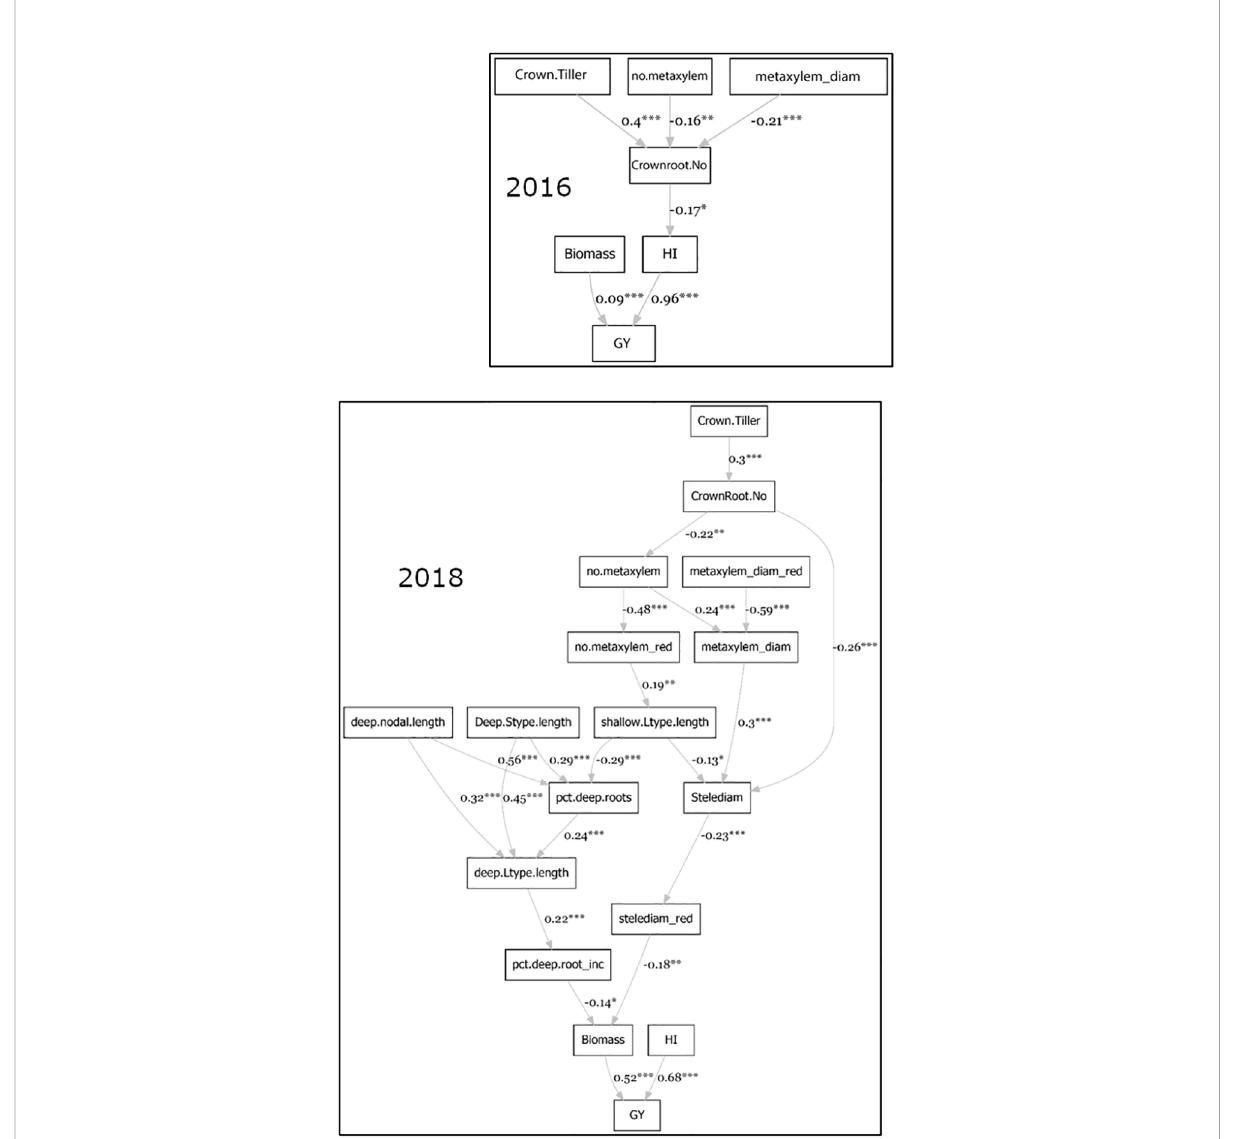
FIGURE 4 Path coef fi cient analysis on agronomic, root anatomical and morphological phenotypes in puddled, transplanted (2016WS; top) and direct seeded (2018WS; bottom) trials on the Thai/SE Asia panel. WS, wet